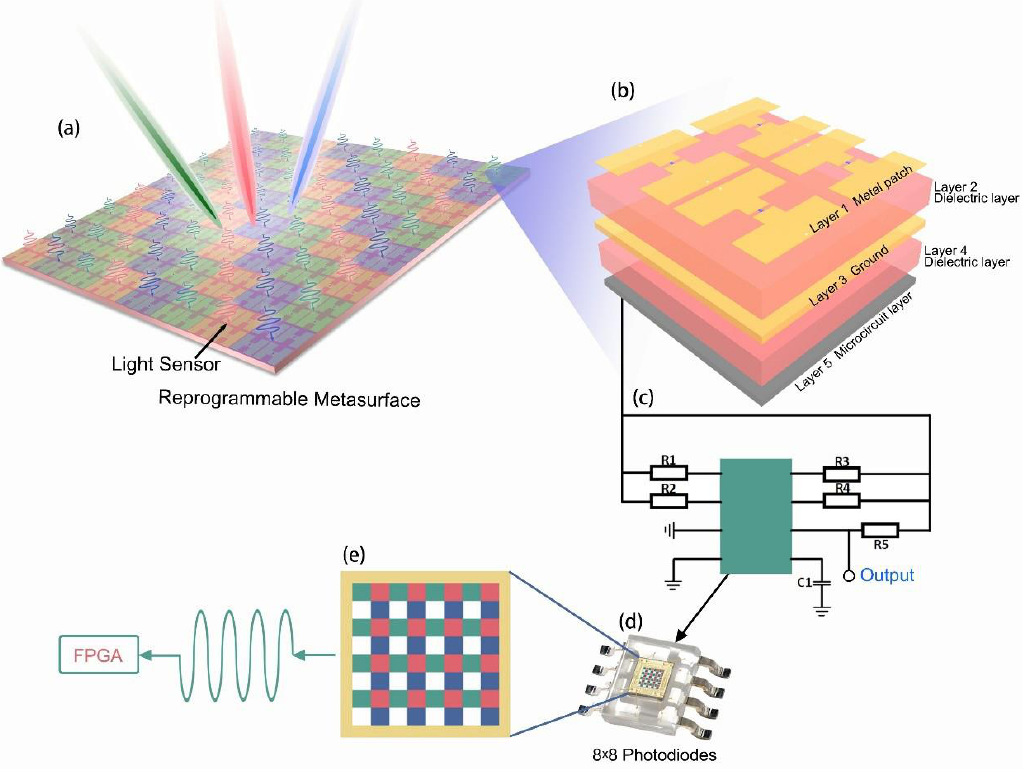
Figure 3. The stereoscopic graph of the meta-atom group structure. ( a ) The digital programmable metasurface. ( b ) The stereoscopic graph structure consists of four meta-atoms. ( c ) Microcontroller module. ( d ) A sample of the color sensor. ( e ) Light-to-frequency converter. The light-to-frequency converter reads an 8 × 8 array of photodiodes.